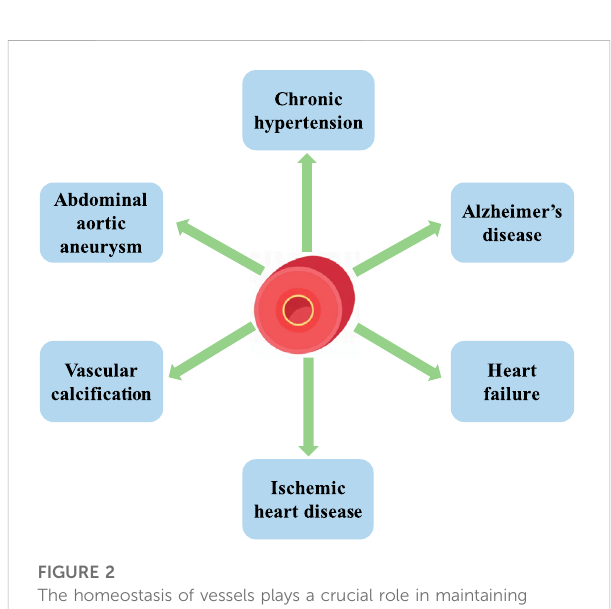
FIGURE 2 The homeostasis of vessels plays a crucial role in maintaining physical fi tnessandpreventingcardiovasculardiseases.Vascularaging causes chronic hypertension, Alzheimer ’ s disease, heart failure, ischemic heart disease, vascular calci fi cation, and abdominal aortic